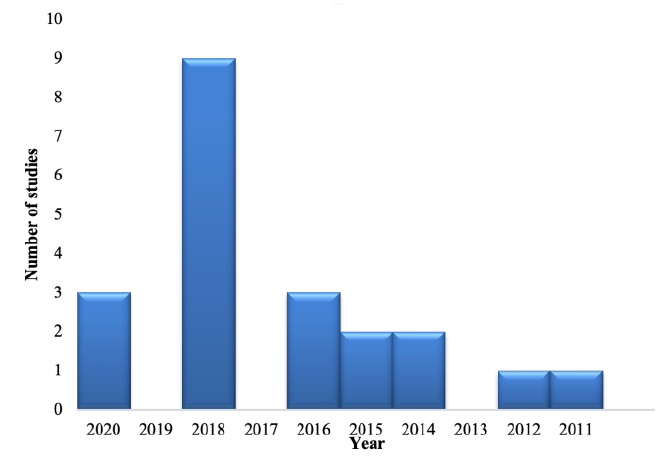
Figure 3: Reviewed studies from 2011 to